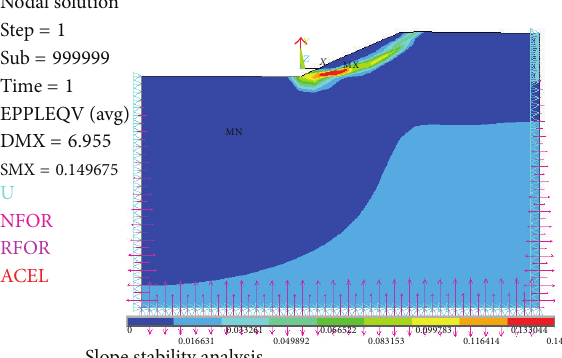
Figure 17: von Mises plastic strain runs through from slope toe to top surface when safety factor equals